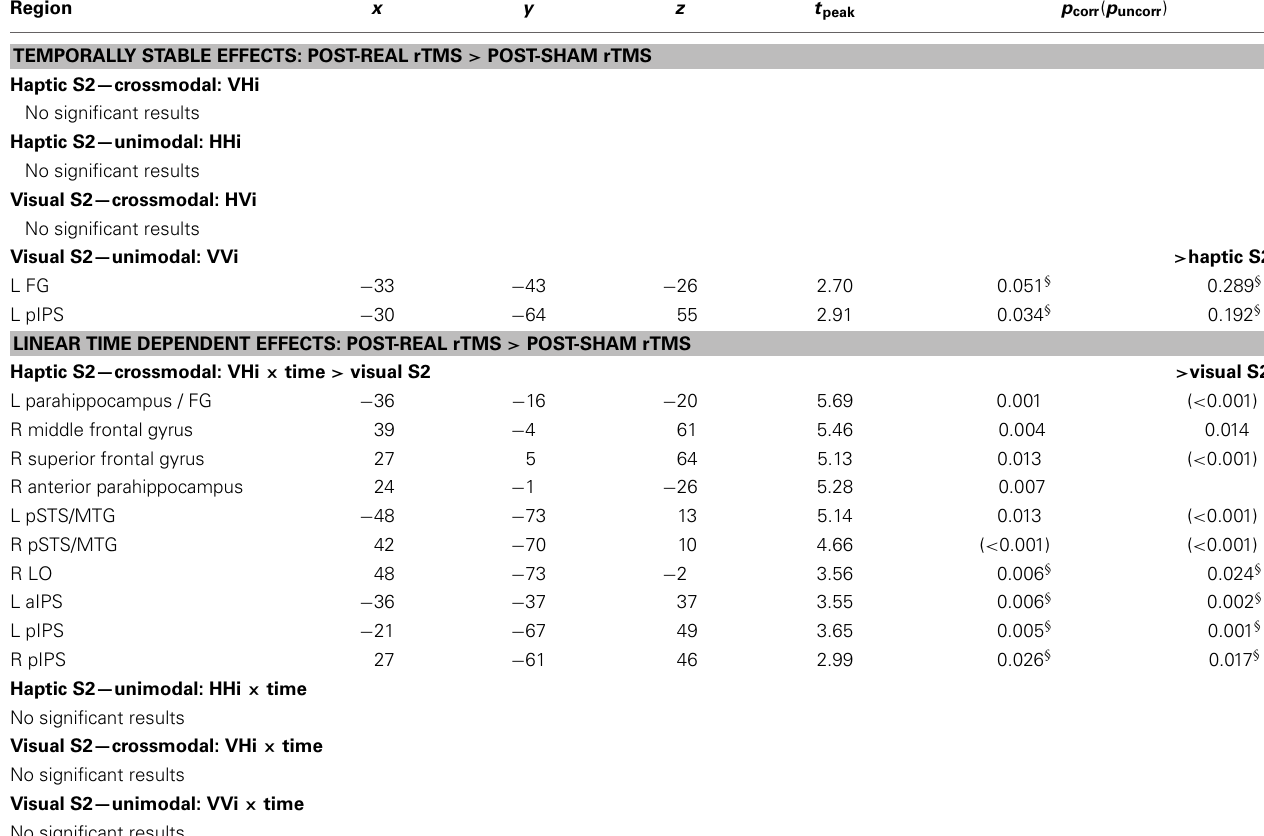
Table 2 | Linear time-dependent effects of rTMS on regional activity during crossmodal incongruent matching. Region x y z t peak p corr ( p uncorr